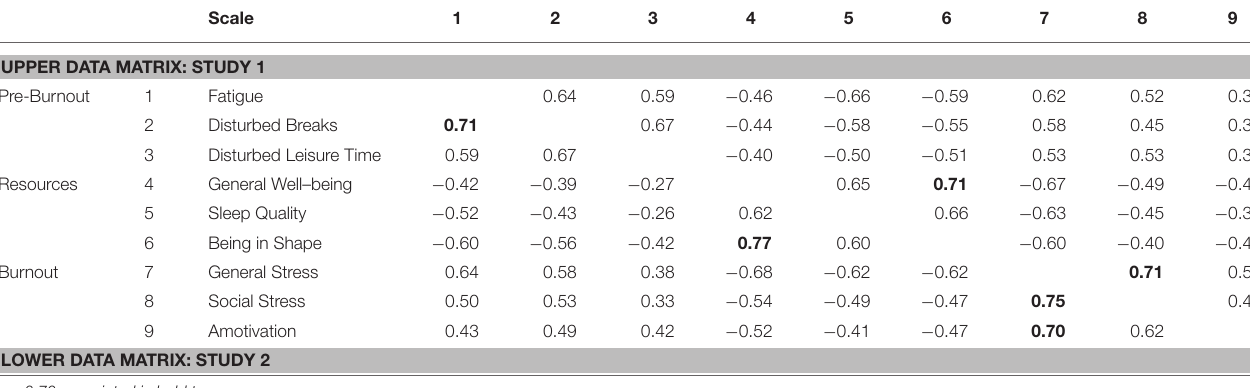
TABLE 8 | Intercorrelations for the samples of study 1 ( N = 233) and study 2 ( N = 473). Scale